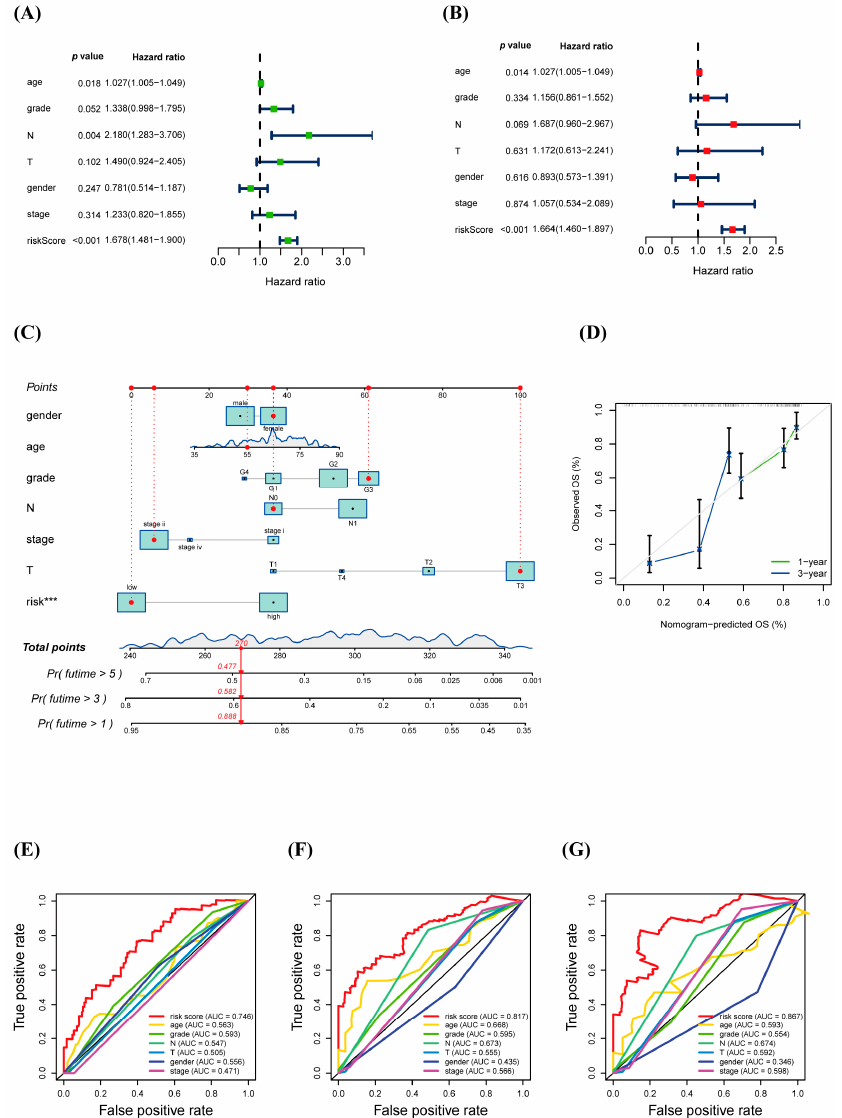
Figure 5. Effects of the risk score model and clinical parameters on the prognosis of PAAD patients. ( A , B ). Identification of the parameters related to OS by univariate ( A ) and multivariate Cox analyses ( B ) in the TCGA training cohort. ( C ) A clinical prognostic nomogram for predicting the 1-, 3-, and 5-year OS of patients with PAAD in TCGA training cohort. ( D – F ) A comparison of 1- ( D ), 3- ( E ),